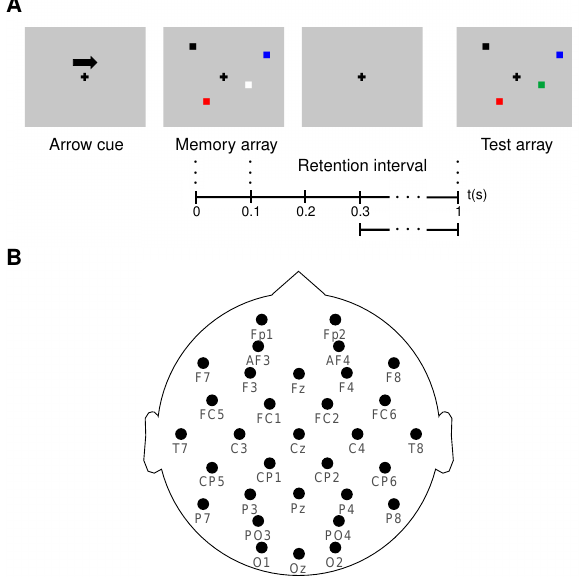
Figure 3. ( A ) Schematic representation of the WM protocol. ( B ) EEG channel montage used for the acquisition of the WM